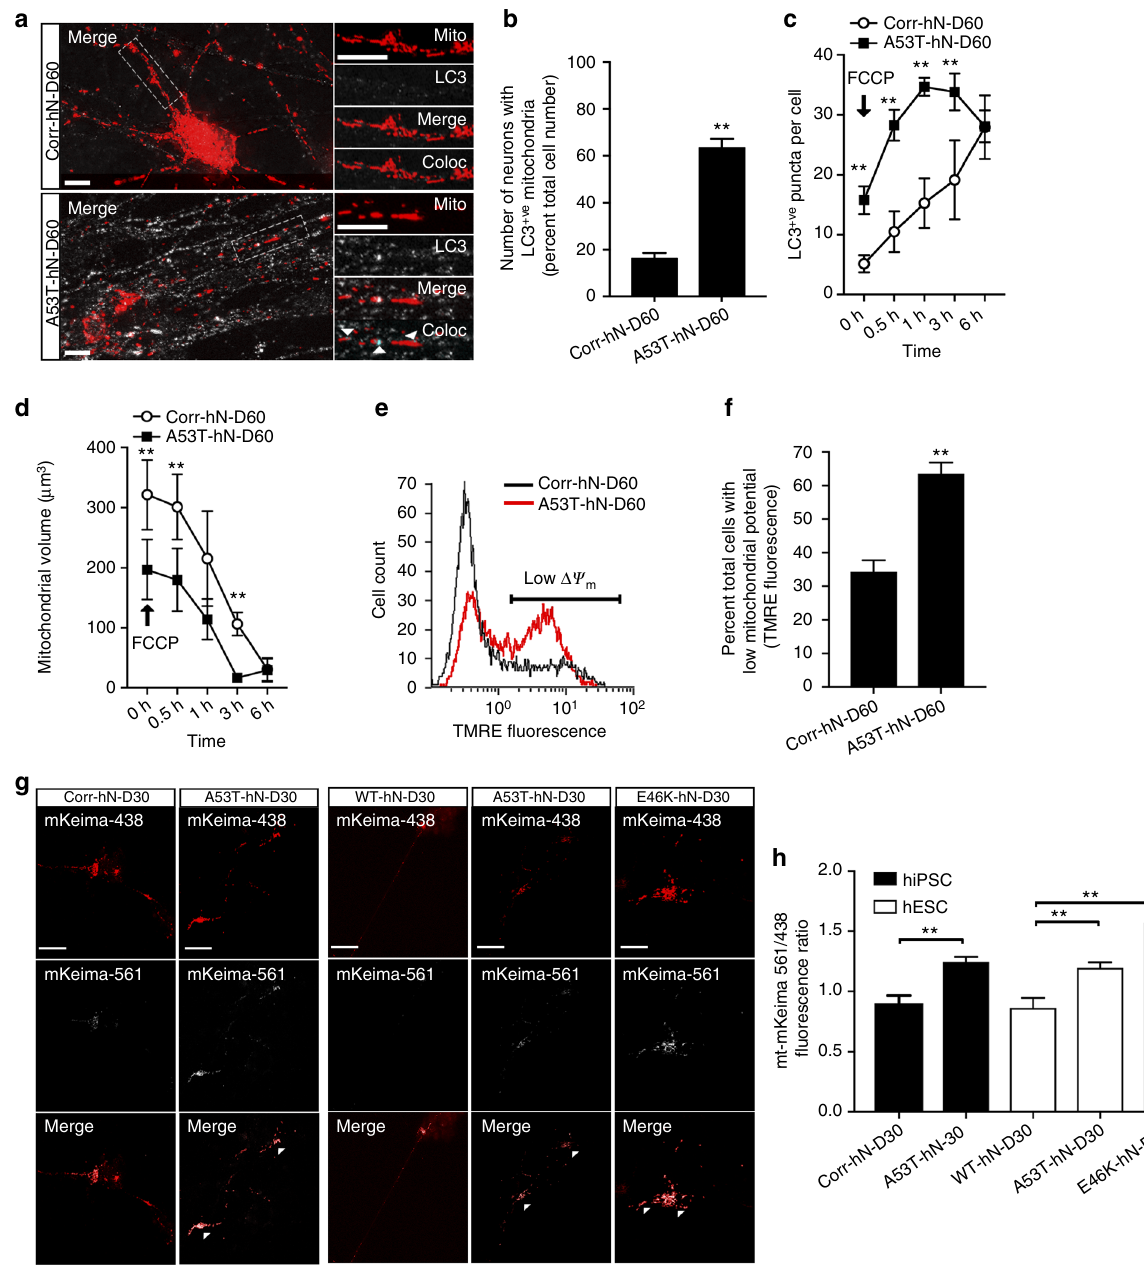
Fig. 3 α -Syn-mutant hNs show evidence of increased mitophagic turnover. a , b A53T hNs display more punctate LC3 staining localizing to mitochondria relative to corrected hNs (top panels) ( a ). Arrows show areas where LC3 colocalizes with MitoDSRed. Boolean operation was employed to label regions of colocalization in blue, scale bar: 10 μ m. Quanti fi cation of cells containing LC3-positive mitochondria ( b ). Data represent mean ± s.e.m. ** P = 0.0002 by t - test, n = 6 coverslips from 2 independent differentiations, DIV: 60. c , d MitoDSRed expressing A53T and corrected hNs were exposed to FCCP and the number of LC3 + ve puncta per neuron ( c ) coupled to the total mitochondrial volume ( d ) was measured over time (360 min). LC3 + ve puncta form more rapidly in A53T-mutant hNs relative to corrected hNs corresponding to an accelerated loss of mitochondria. Data represent mean ± s.e.m. ** P < 0.01 by repeated measures ANOVA with multiple t-test, n = 3 coverslips from 2 independent differentiations, DIV: 60. e, f A53T and corrected hNs were labeled with 200 nM TMRE, and mitochondrial potential ( ΔΨ m ) was measured by fl ow cytometry using the dequench method. Representative plot showing forward scatter and TMRE fl uorescence as a measure of cell size and ΔΨ m , respectively ( e ), as well as the percent depolarized cells ( f ) illustrate that A53T hNs have lower mitochondrial potential than corrected hNs. ** P = 0.0039 by t -test, n = 3 coverslips from 3 independent differentiations, DIV: 60. g , h Autophagic fl ux was measured by mt-mKeima targeted to the autolysosome. Targeting of mKeima to the lysosomal compartment results in a fl orescence shift in excitation from 438 nm (red) to 561 nm (white) ( g ). hiPSC-derived A53T hNs and hESC-derived A53T and E46K hNs had a higher ratio of 561 nm to 438 nm fl uorescence than their corrected or WT counterparts, respectively ( h ). ** P < 0.01 ANOVA followed by Tukey ’ s post hoc test, for hiPSC n = 12, for hESCs, n = 8 coverslips from 3 independent differentiations, DIV: